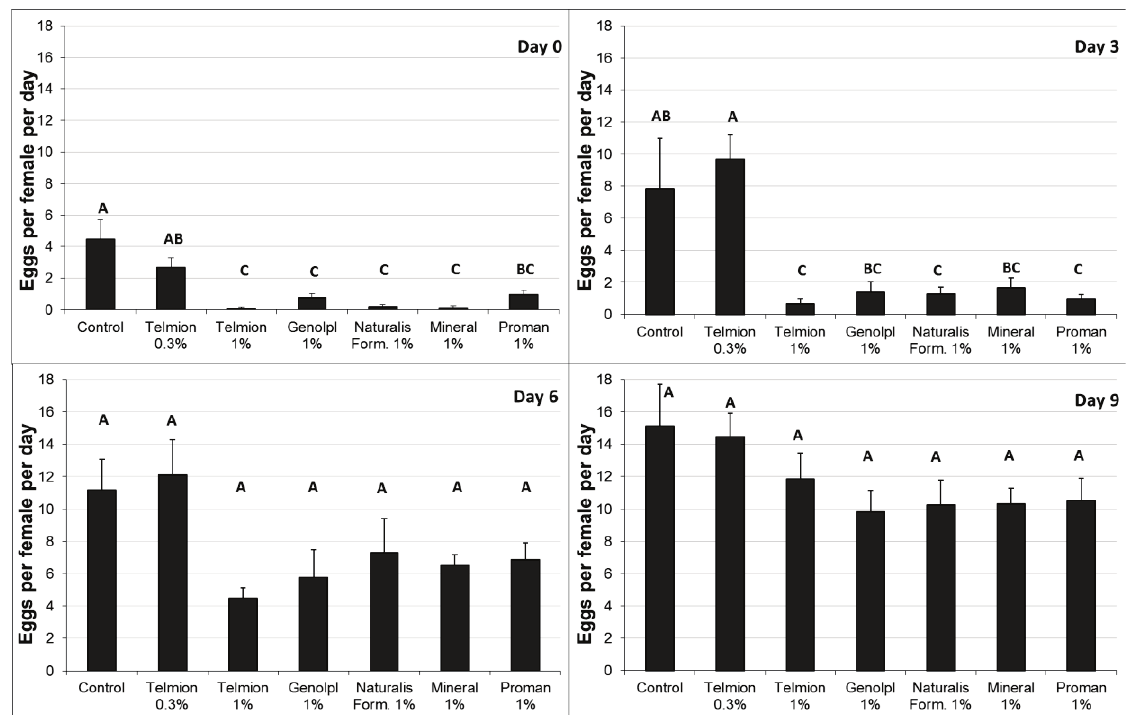
Figure 2. First semi-field experiment: Number of eggs per female per day (±se) in fruit samples exposed for oviposition immediately (0 day) and 3, 6 and 9 day after treatment.